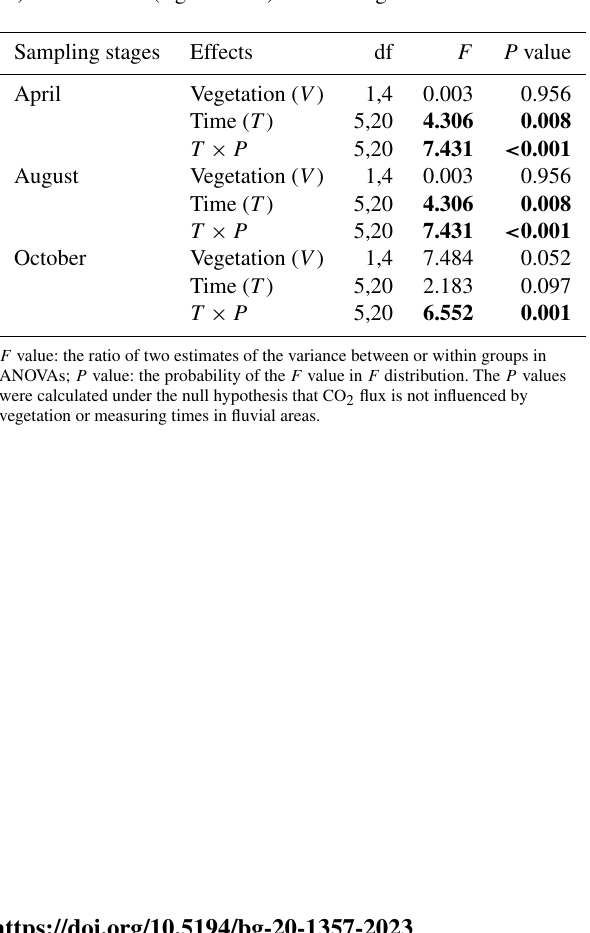
Table A2. Repeated ANOVA measurements for the effects of veg- etation (shallow area with vegetation vs. deep area without vege- tation; between-subject factor) and time (measuring times in 1d; within-subject factor) on CO 2 fluxes in three sampling stages (April, August, and October) in fluvial areas. Degree of freedom (df) and F and P (significance) values are given.